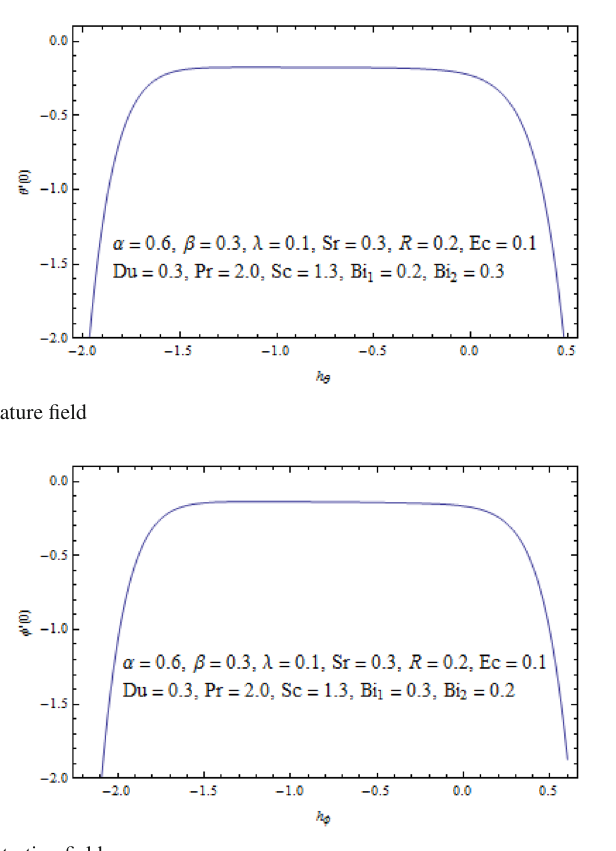
Fig. 3 (cid:2) φ − curve for concentration field Table 1 Convergence of series solutions for different order of approximations Order of